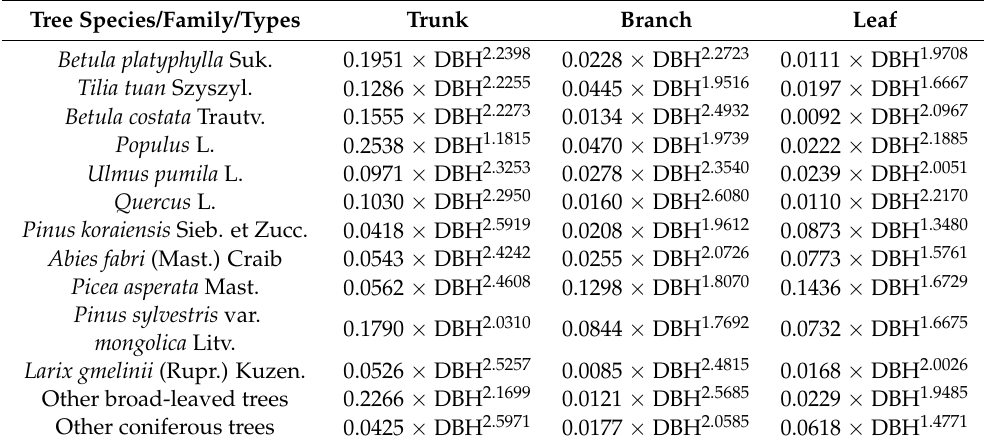
Table 1. The allometric growth equation for calculating forest aboveground biomass (AGB) by diameter at breast height (DBH).